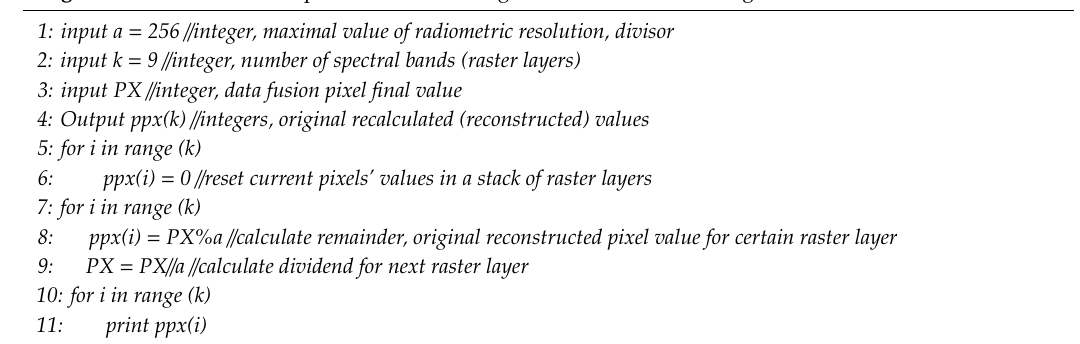
Algorithm 2 Reed-Solomon pixel-level reverse algorithm for remote sensing data